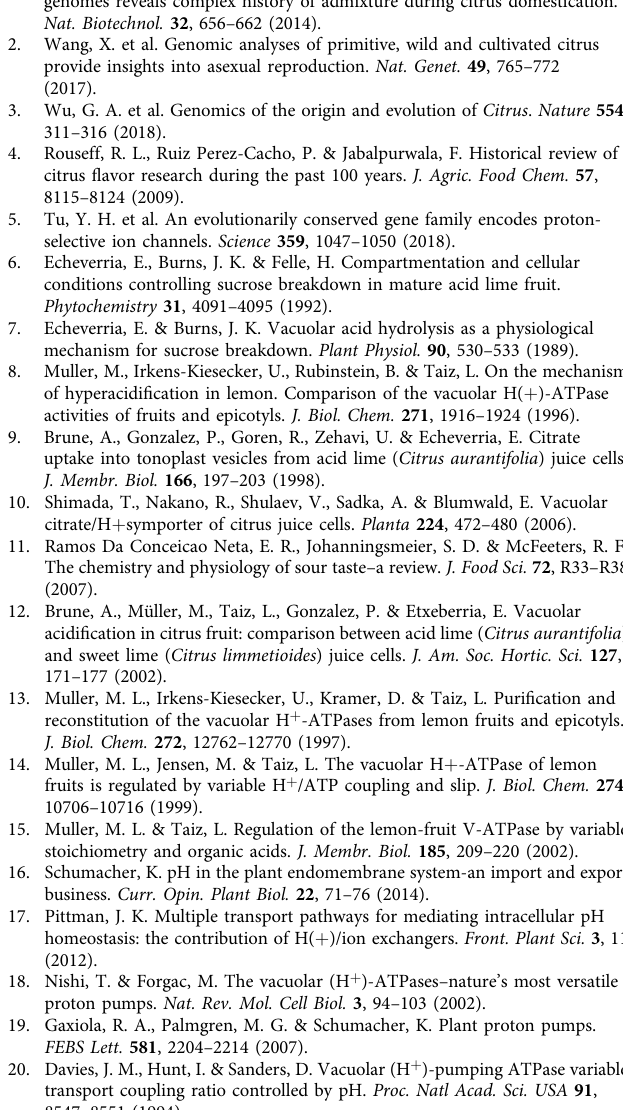
Supplementary Table 3. cDNA products were ampli fi ed using primers speci fi c for PH1 (primers 6524 and 4383), PH5 (primers 6530 and 6529), AN1 (primers 6623 and 6593, for the Fsw allele : primers 6623 and 6592), PH3 (primers 6538 and 6540), PH4 (primers 6544 and 6546), AN11 (primers 6614 and 6615), and ACTIN (primers 58a and 59a). All primer sequences are reported in